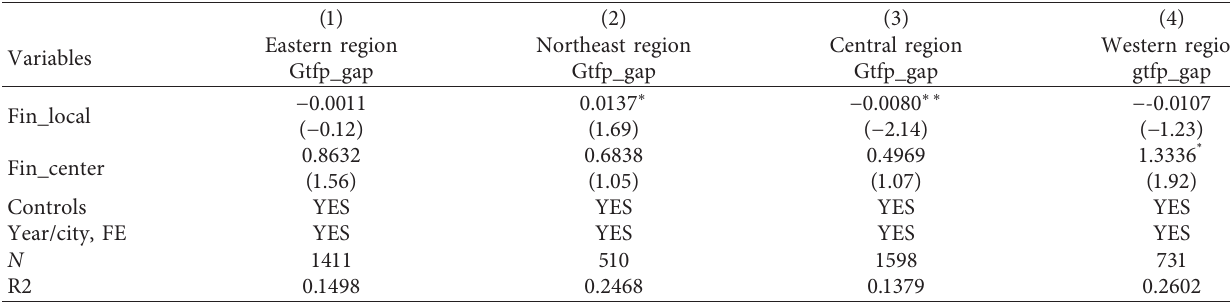
Figure 2: Dynamic evolution figure of the gap of regional green development. Table 7: Location